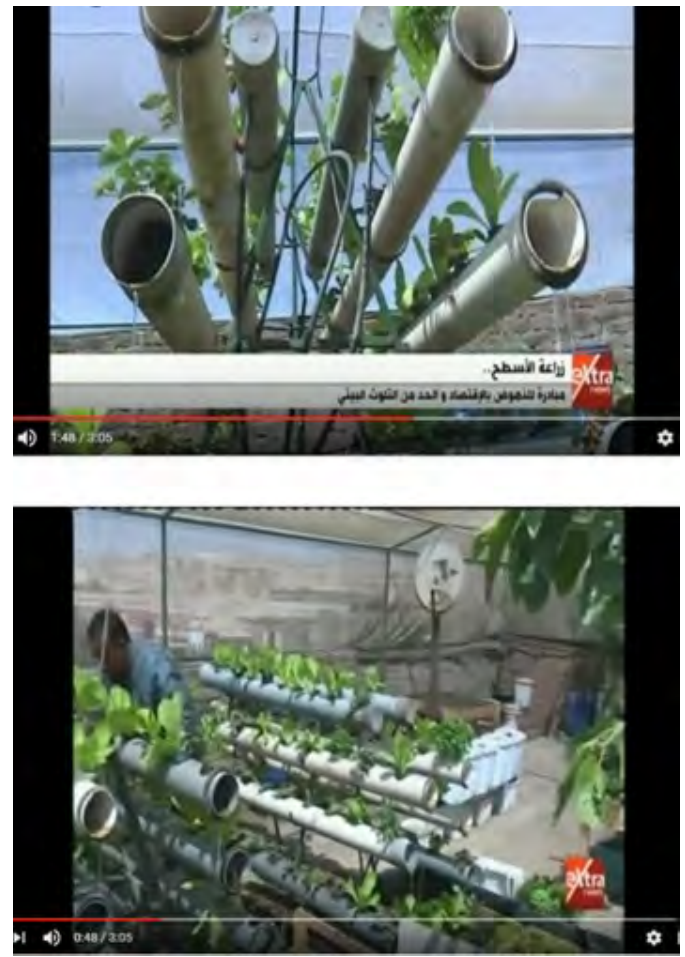
Figure 9. (Aquaponic system case). (Hydroponic &Aquaponic systems, Extra News,